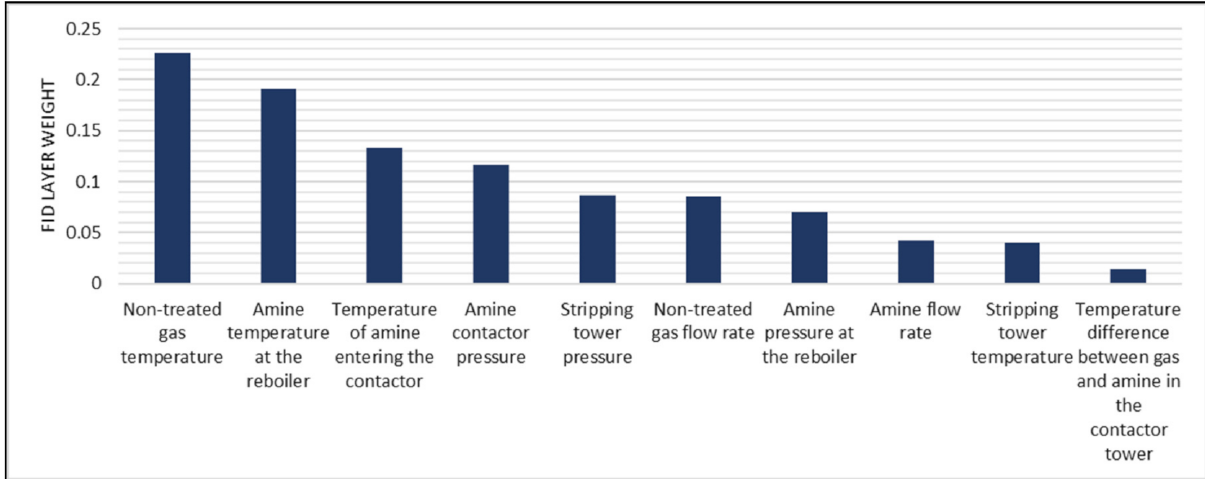
Figure 14. Ranking of features according to the FS layer